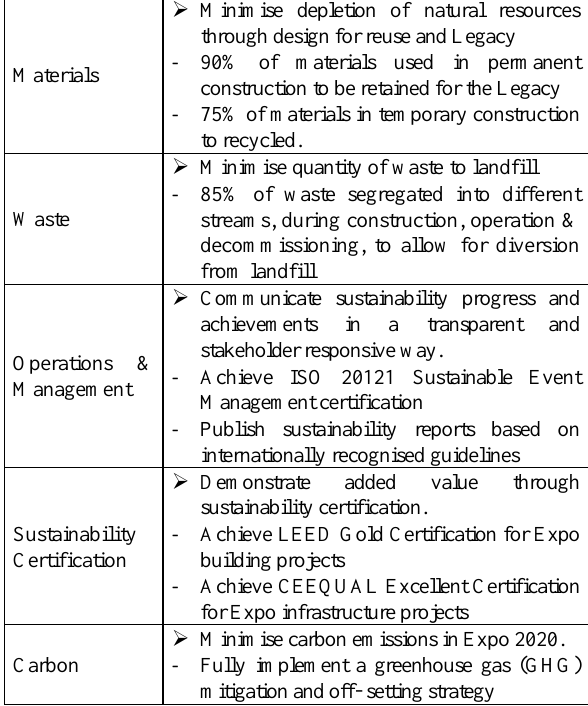
Table 1 . Dubai Expo 2020 - Sustainability Criteria,